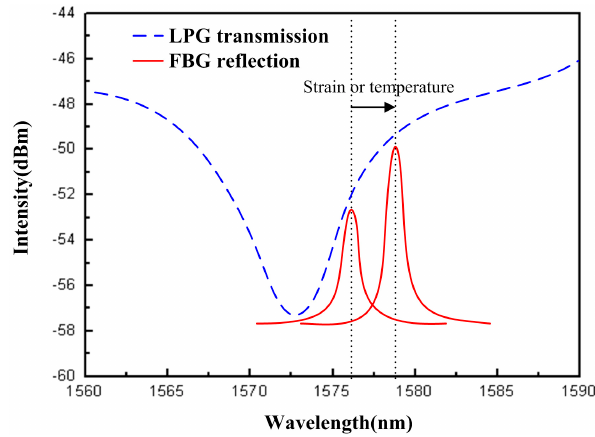
Figure 2. The schematic spectra of the LPG and FBG structures.